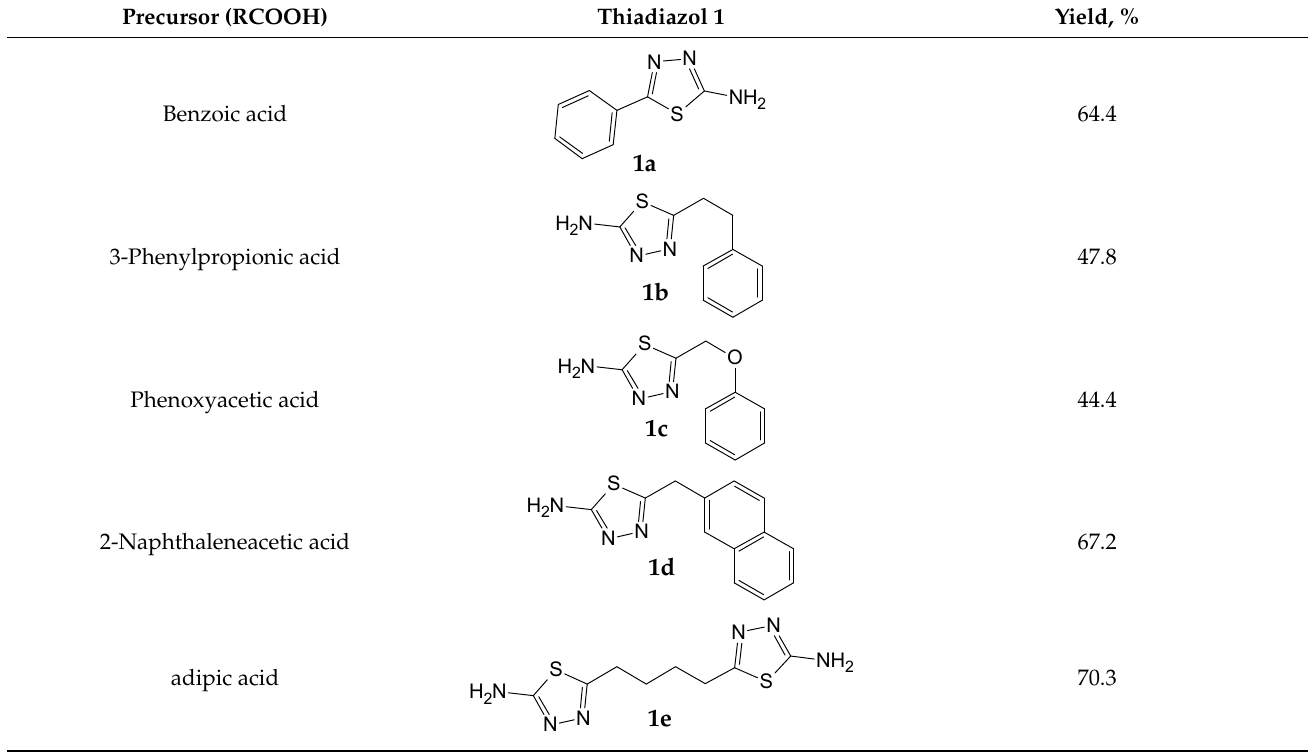
Table 1. List of 2-amino-1,3,4-thiadiazoles synthesized using the developed approach (Scheme 1). Precursor (RCOOH)